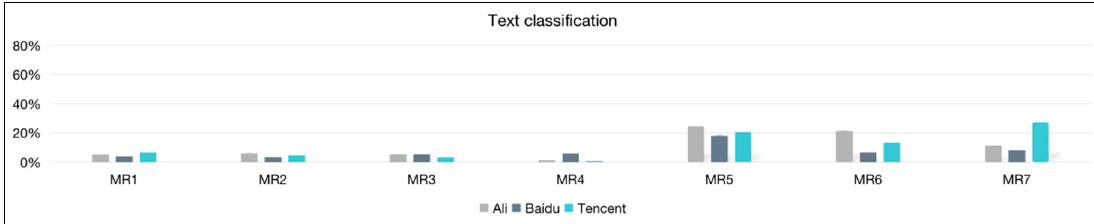
Figure 7. VR of 3 NLP systems on text classification.